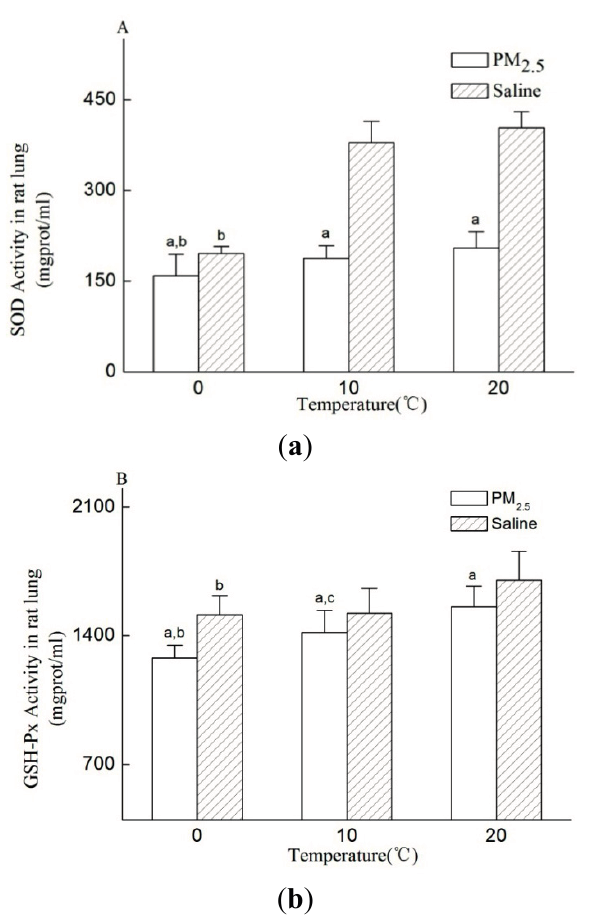
Figure 4. The level of oxidant and antioxidents in rat lung. ( A ) SOD, ( B ) GSH-Px, ( C ) MDA. n = 8/group, instillation of PM (8 mg/rat). Data represent as the mean ± SD. 2.5 Significance: a p < 0.05 compared to the corresponding cold stress alone group; b p < 0.05 compared to the normal temperature group with saline or PM ; c p < 0.05 compared to 2.5 0 °C group with saline or PM 2.5